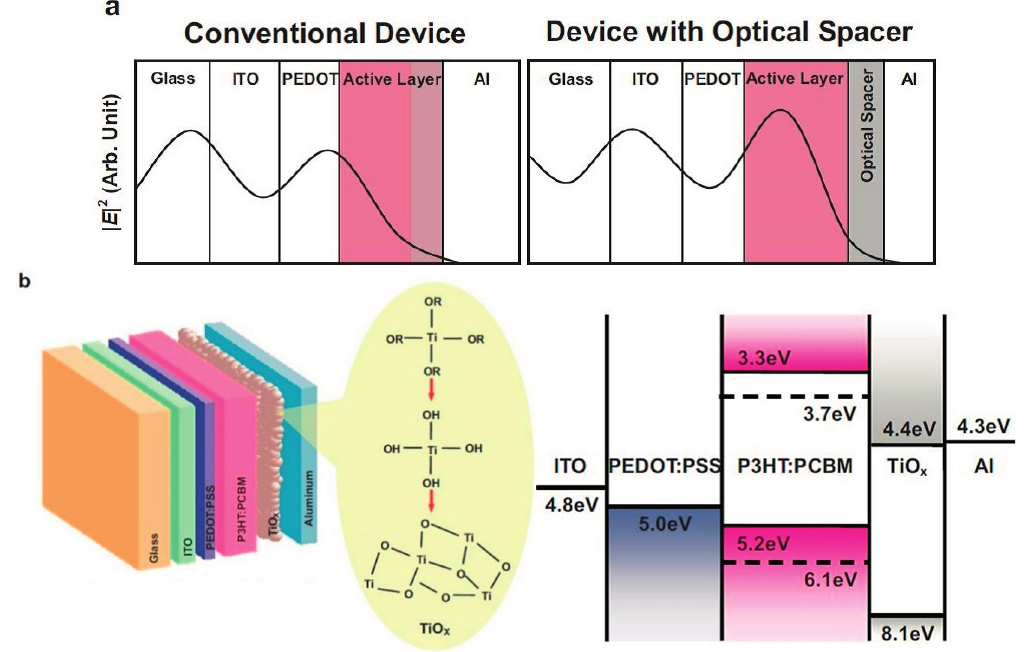
Figure 17. ( a ) Schematic illustration of the squared spatial electric field, | E | 2 , spatial distribution inside the solar cells with a structure of ITO/PEDOT/active layer/Al (left) and ITO/PEDOT/active layer/optical spacer/Al (right); ( b ) Schematic illustration of the device structure (left) with a brief synthetic route to the TiO x interfacial layer and the energy level diagram (right) of the single components of the polymer solar cells. Reprinted with permission from [106]. Copyright 2006 Wiley-VCH Verlag GmbH & Co.